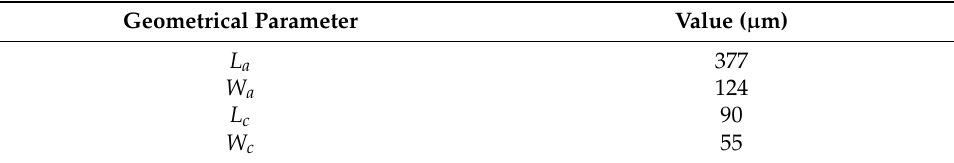
Table 2. The geometrical parameter values for the optimized